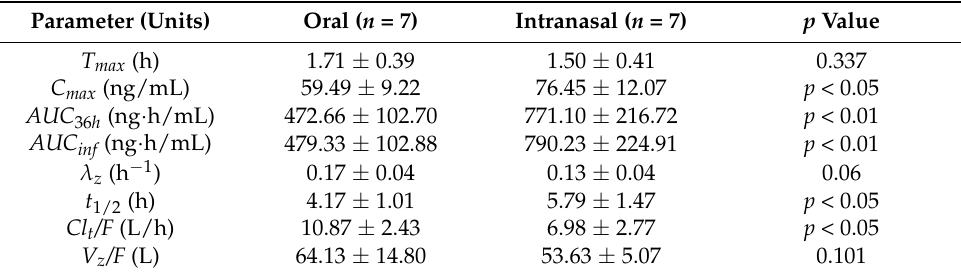
Table 1. Noncompartmental pharmacokinetic parameters for the oral and intranasal administration of 5 mg tadalafil to dogs. Data are presented as the mean ± standard deviation (SD).